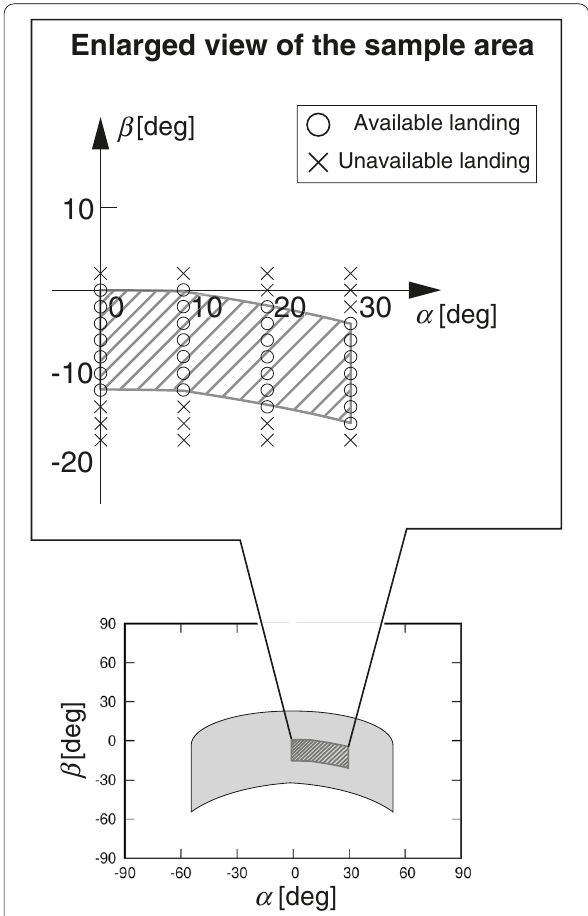
Fig. 13 The selected sample area for